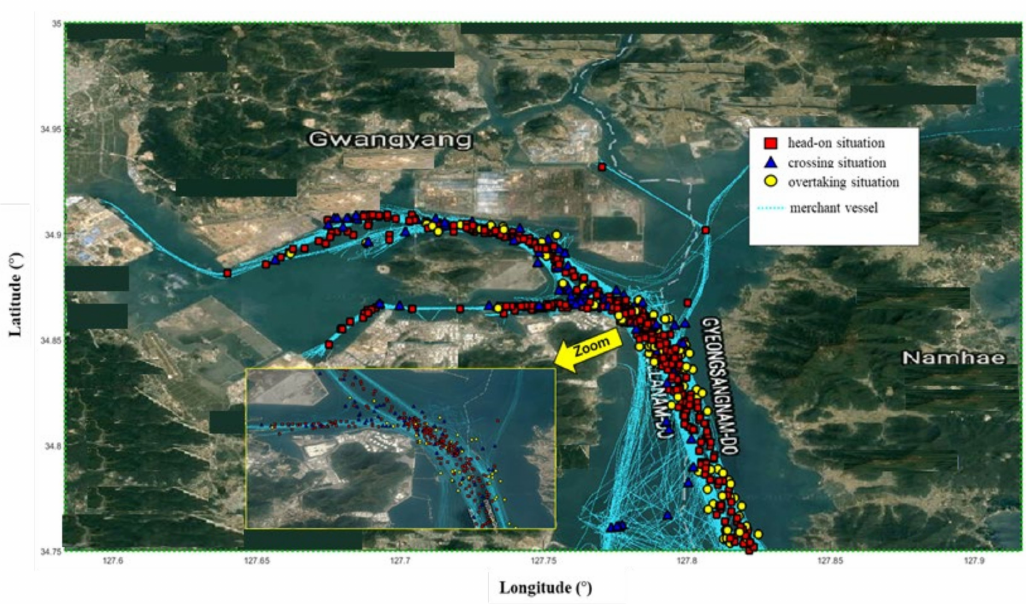
Figure 4. Scatter plot for the near-miss location between merchant vessels in Yeosu VTS area; head-on ( red square ), crossing ( blue triangle ), overtaking situation ( yellow circle ), and merchant vessels trajectories ( cyan dotted line